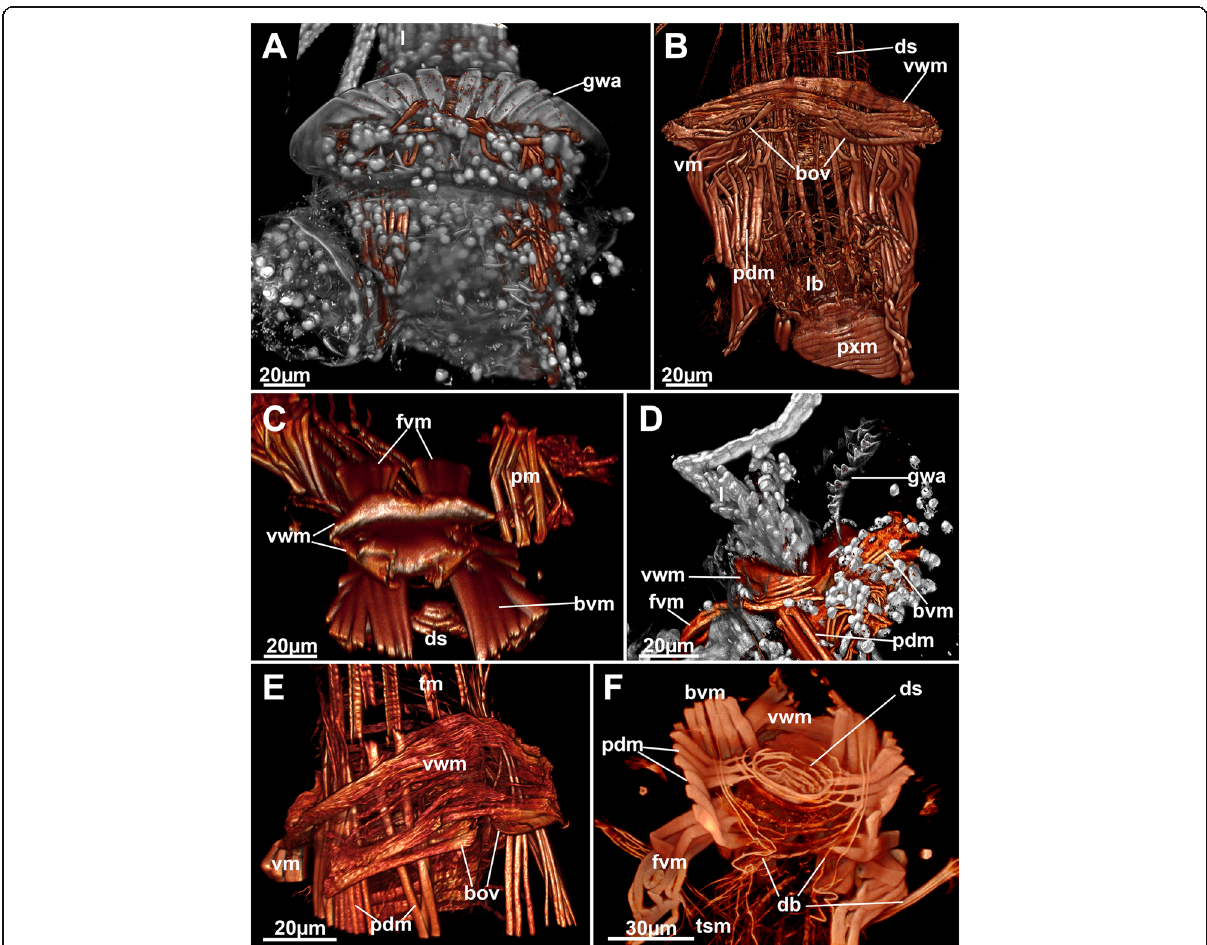
Fig. 8 Detail of the apertural area and musculature of Hypophorella expansa . f-actin (glow), nuclei and autofluoescence (gray), CSLM, volume rendering. a Basal view of the apertural area showing a partially protruding polypide and an everted gnawing apparatus. b Same as in A, showing the musculature only. c View of the bilateral arrangement of the vestibular wall muscles in form of ‘ vestibular lips ’ . d Lateral view of the partially protruded lophophore and gnawing apparatus. e Detail of the basal side of the vestibular wall muscles and associated apertural muscles. f Basal view of the apertural area showing the diaphragmatic sphincter. Abbreviations: bov – open bundles of the vestibular wall muscles, bvm – basal vestibular muscles, db – duplicature band, ds – diaphragmatic sphincter, fvm – frontal vestibular muscles, gwa – gnawing apparatus, lb. – lophophoral base, pdm – parieto-diaphragmatic muscles, pxm – pharyngeal ring muscles, tm – tentacle muscles, vm – vestibular muscles, vwm